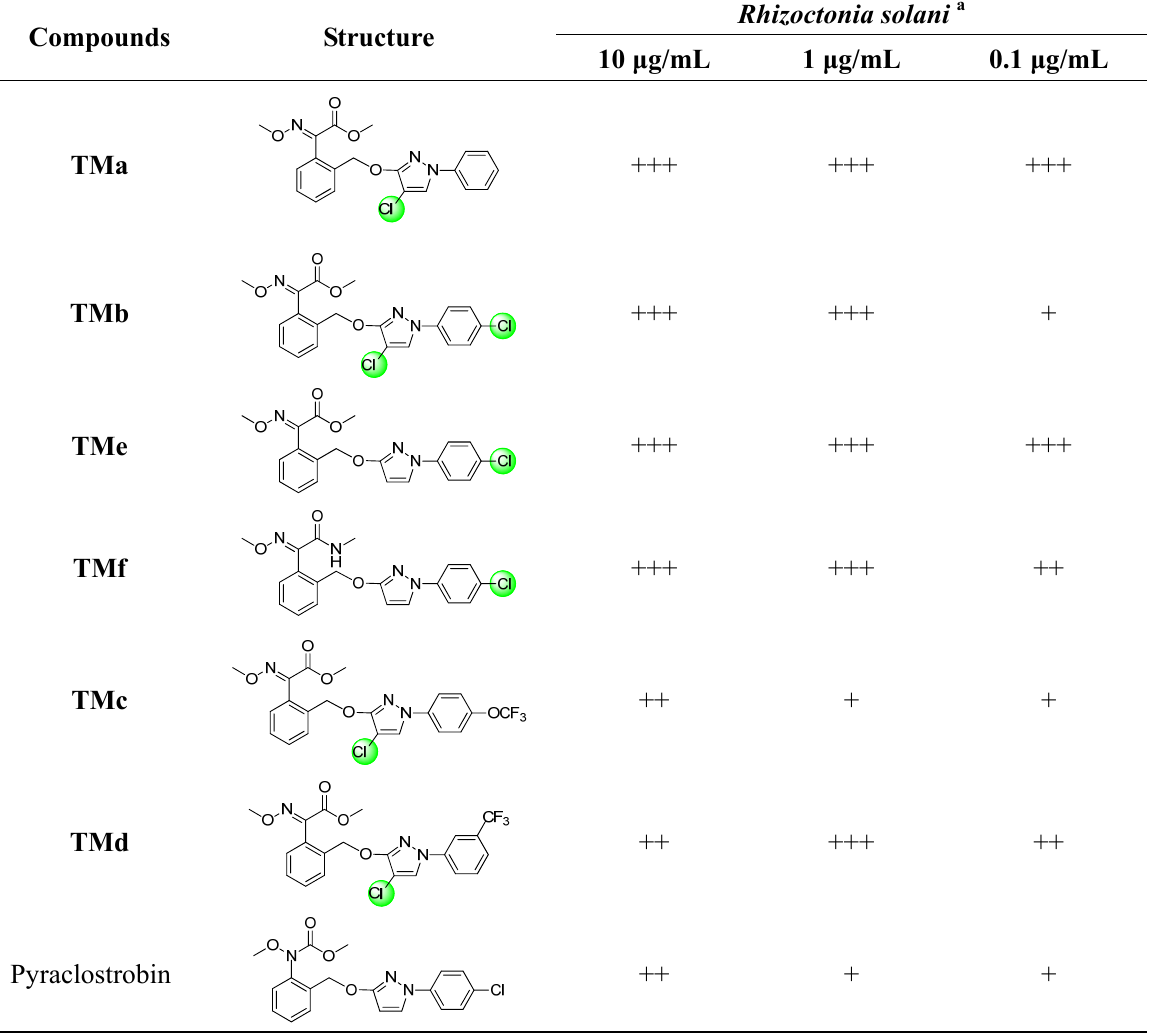
Table 2. Antifungal activity and EC